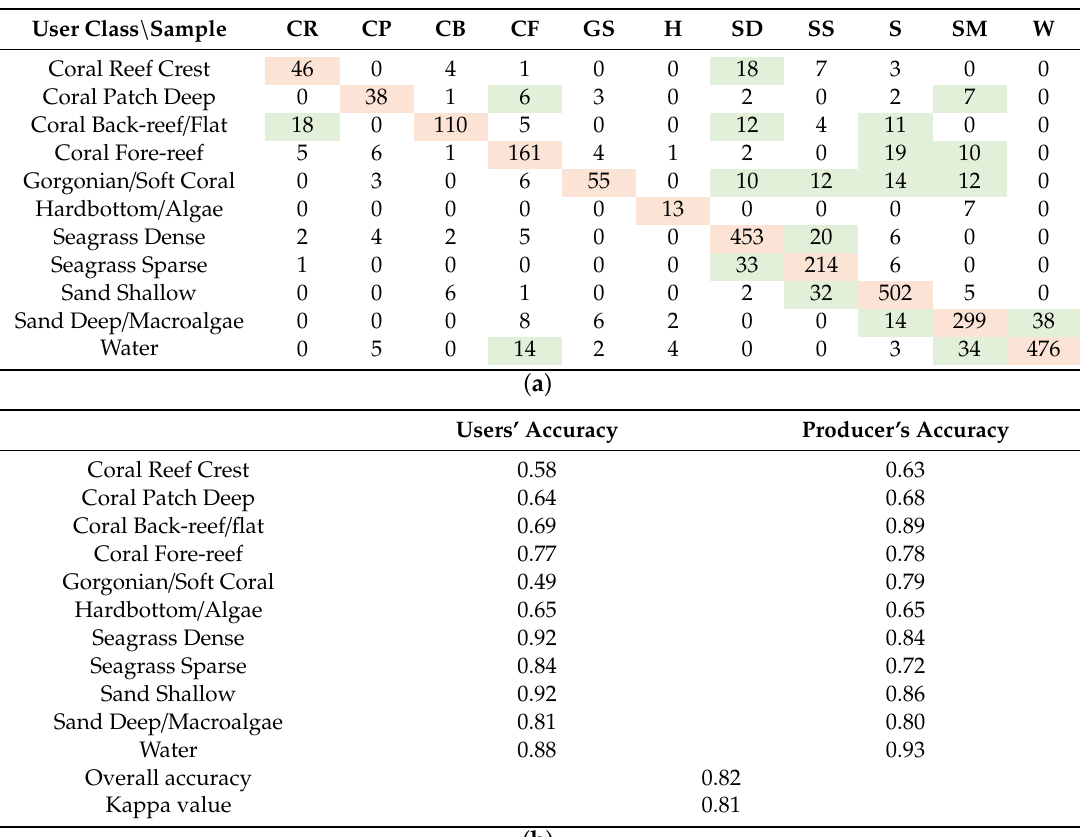
Table 2. ( a ) Confusion matrix results for accuracy assessment for Coral Reef Crest (CR), Coral Patch Deep (CP), Coral Back-reef / flat (CB), Coral Fore-reef (CF), Gorgonian / Soft Coral (GS), Hardbottom / Algae (H), Seagrass Dense (SD), Seagrass Sparse (SS), Sand Shallow (S), Sand Deep / Macroalgae (SM), Water (W). Orange color indicates correct classification while green color represents wrong classification. ( b ) Classification accuracy assessment.